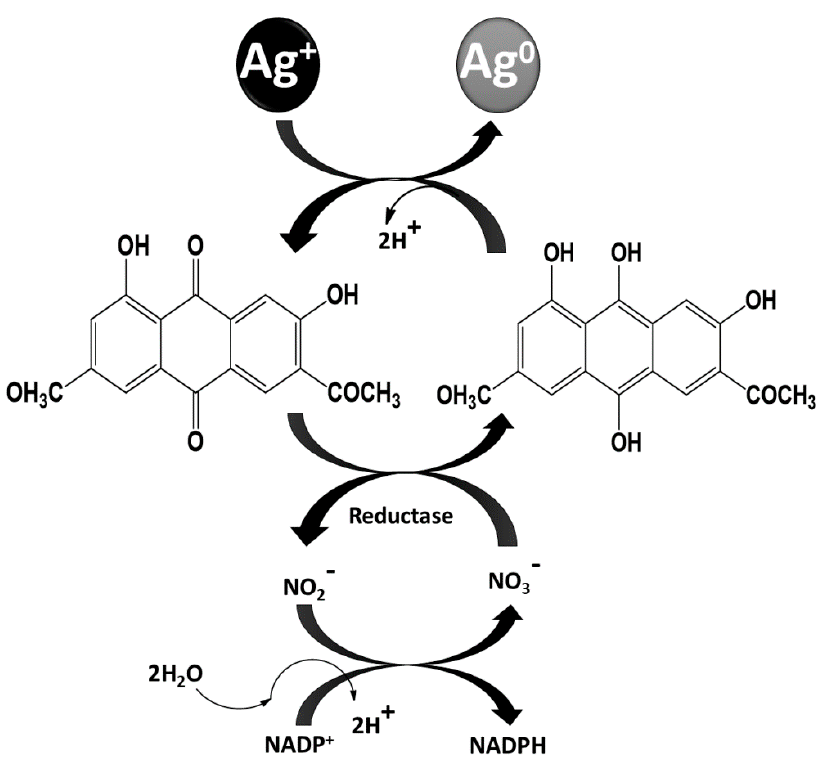
Figure 4. Hypothetical mechanism of AgNPs biosynthesis from F. oxysporum (Adapted from Duran et al. [67], an open-access article).